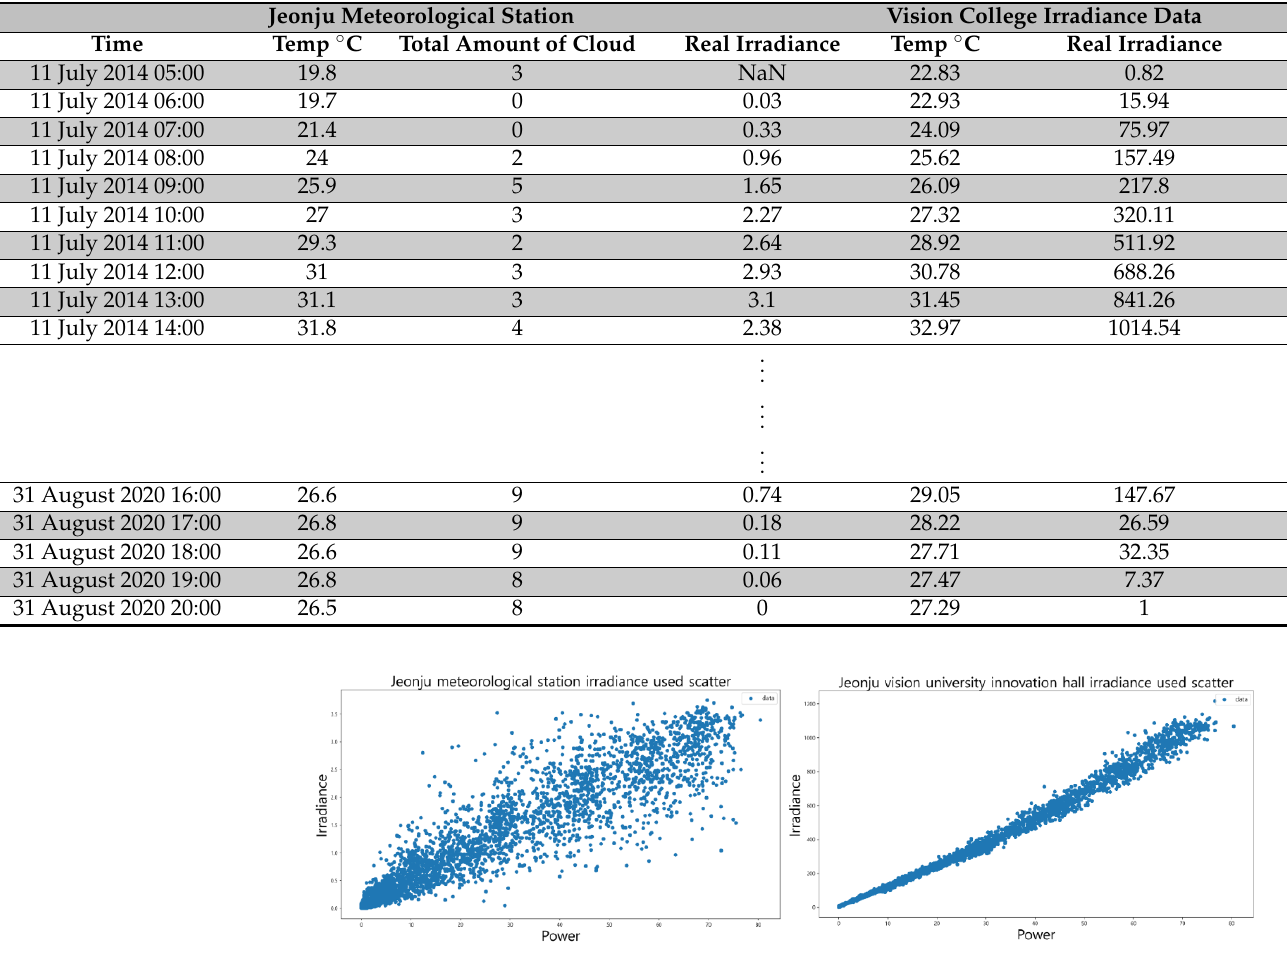
Figure 4. Two generation-irradiance scatter plots based on the generation amount of the non- generation SPV power